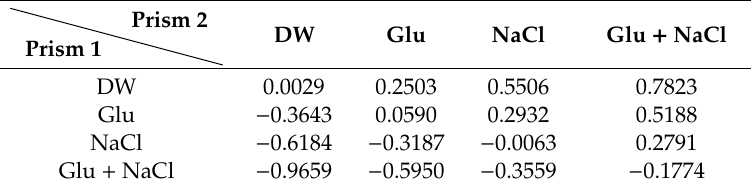
Table 1. The value of the system center wavelength shift amount when a di ff erent solution is passed through the flow path of prism 1 and prism 2. DW: deionized water.